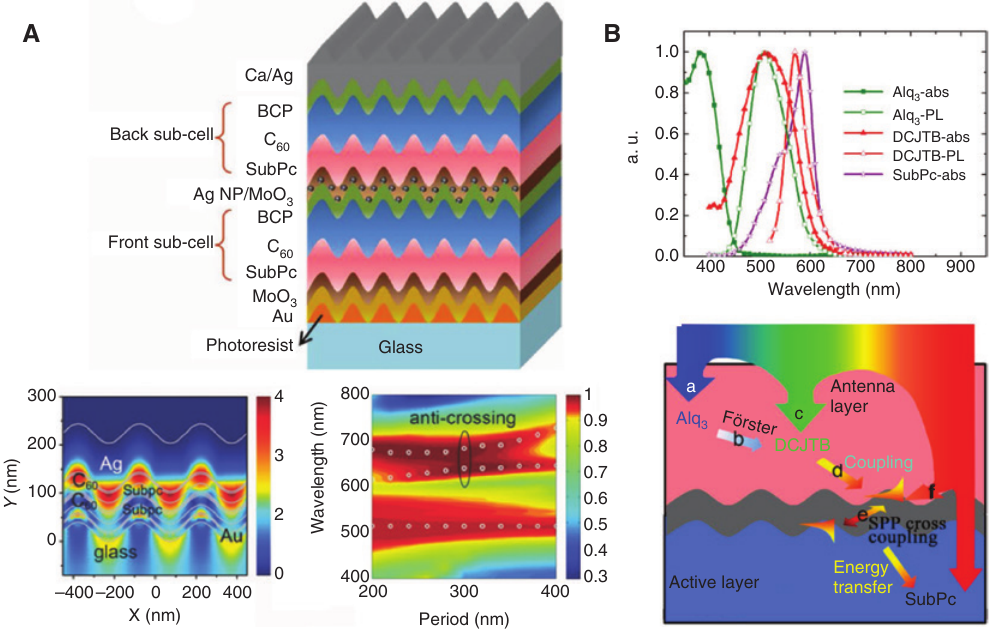
Figure 12: Optical mode cross-coupling in OPVs. (A) Device structure (up), simulated distribution of the magnetic field intensity (left bottom) and dispersion relationship (right bottom) of the corrugated microcavity tandem OPVs (reprint with permission Ref. [179]; Copyright 2013 Wiley-VCH Verlag GmbH and Co. KGaA, Wein- heim). (B) The absorption and the PL spectra of the antenna material and the donor material boron subphthalocyanine chloride (SubPc) (up), and the energy transfer mechanism in the corrugated antenna-based OPVs (bottom) (reprint with permission Ref. [180]; Copyright 2015 AIP Publishing